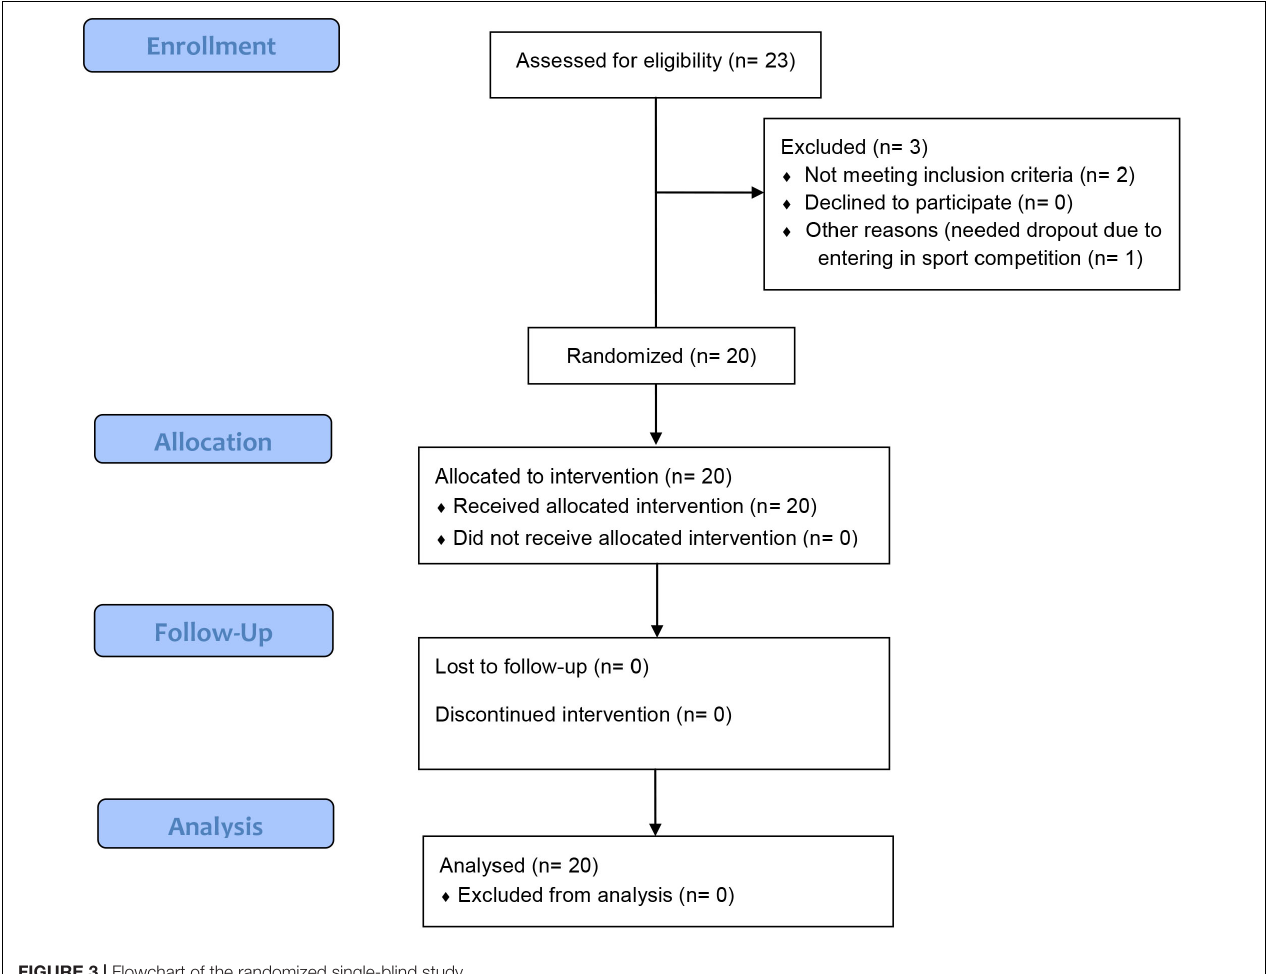
FIGURE 3 | Flowchart of the randomized single-blind study. TABLE 1 | Maximal voluntary contraction (MVC), absolute, and normalized maximum electrically induced contraction (MEIC), current amplitude, and current efficiency at different hip and knee angles.